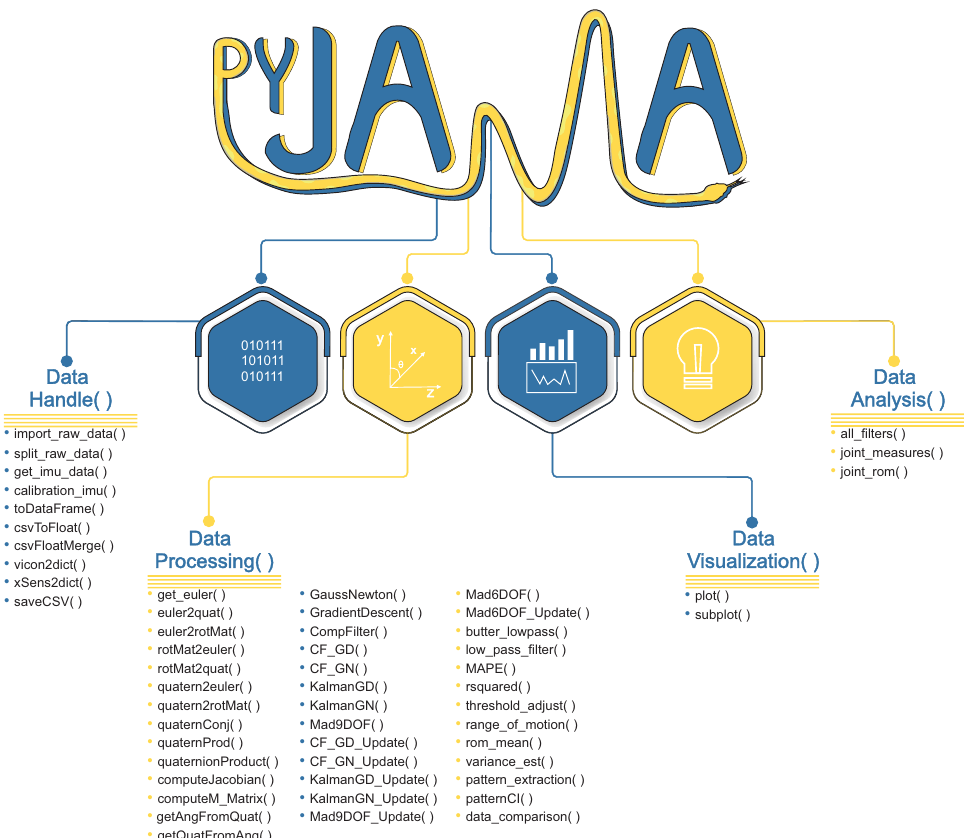
Figure 2. PyJama organization consists of four main classes to handle data formats, processing data, visualization, and analyze